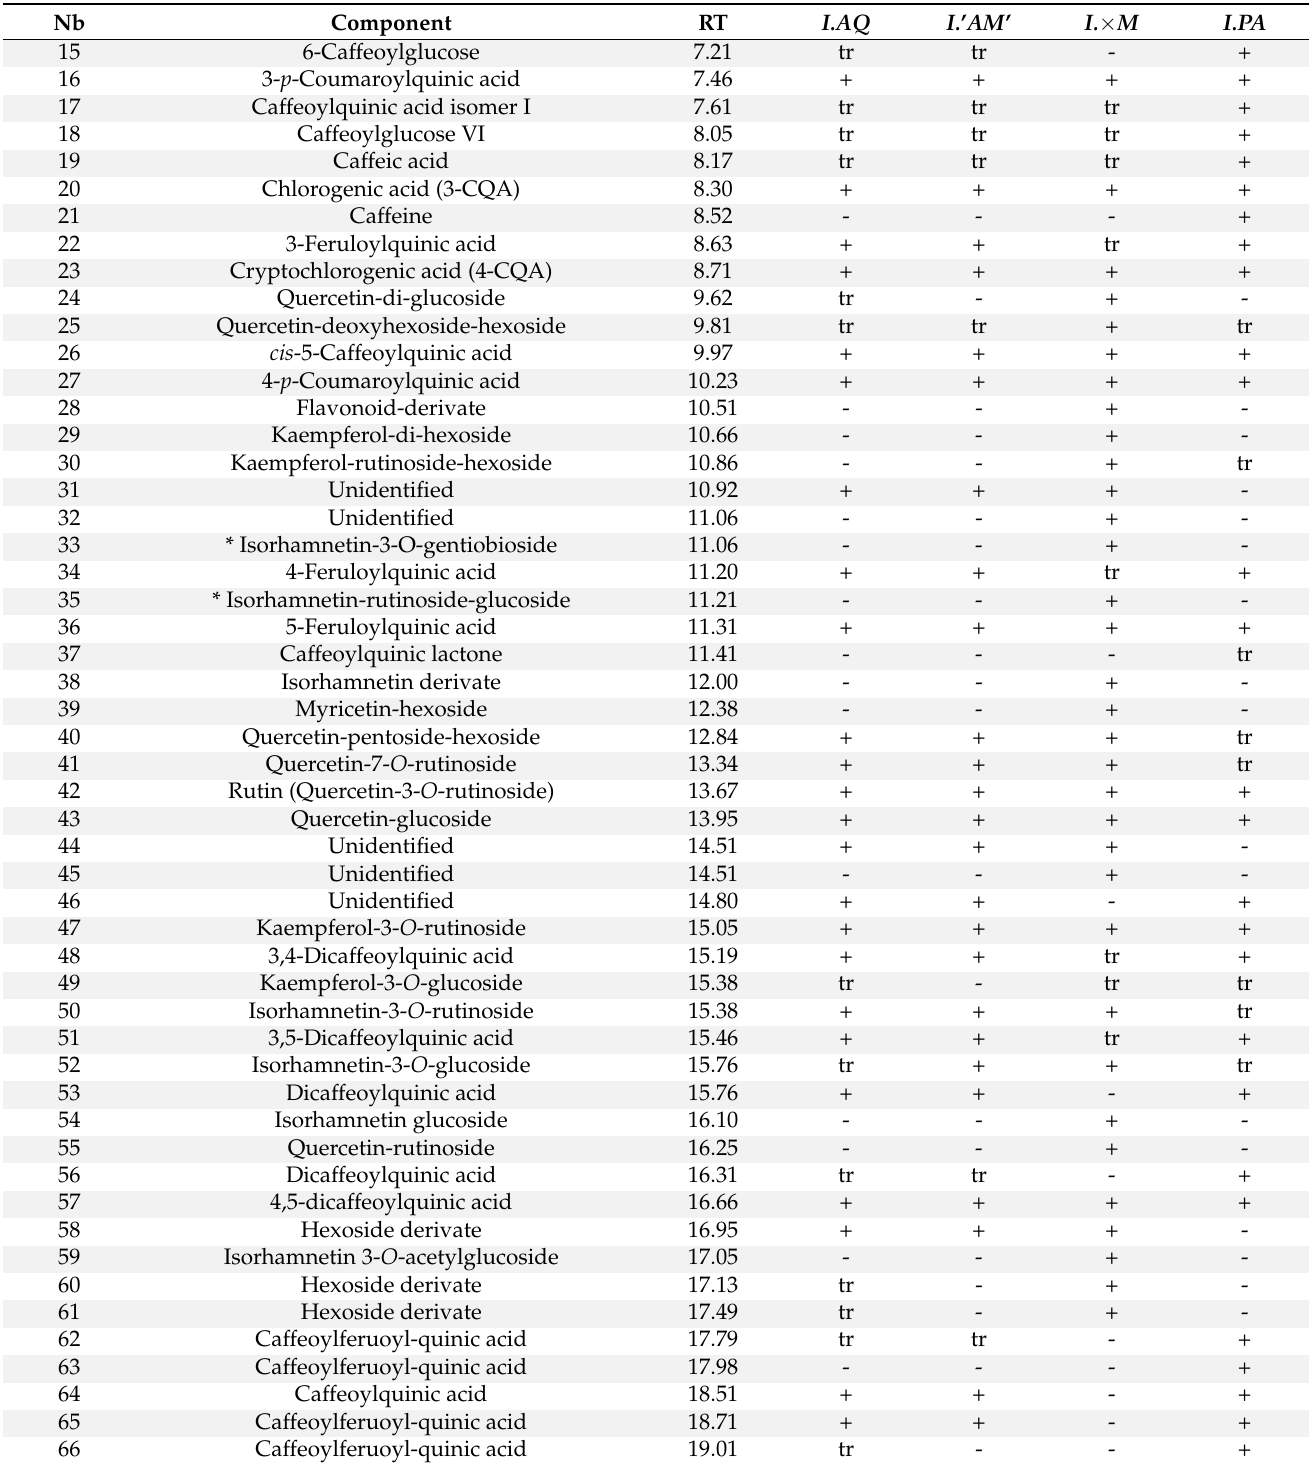
Table legend: + component present;—component absent; * tentatively identyfied component (lack of accurate spectral literature database); tr—trace ions (deprotonated molecules) were observed; I.PA —yerba mate, I. paraguariensis ; I.AQ — I. aquifolium ; I .’ AM ’— I. aquifolium ‘Argentea Marginata’; I. × M — I. × meserveae ‘Blue